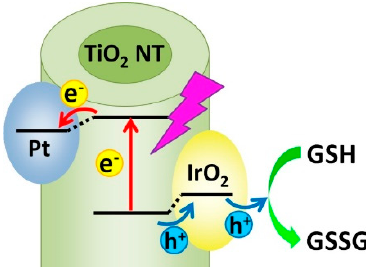
Table 1. Comparison of various GSH sensors.